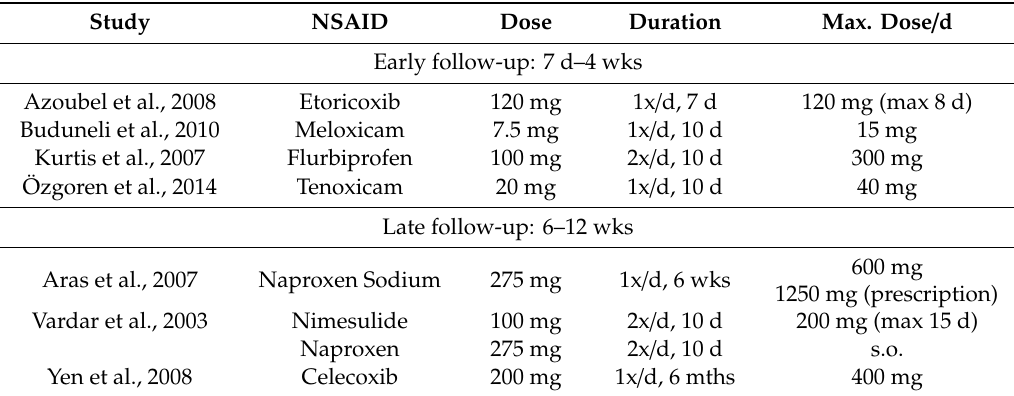
Table 2. NSAID dose and duration of follow-up in studies included in the quantitative assessment.